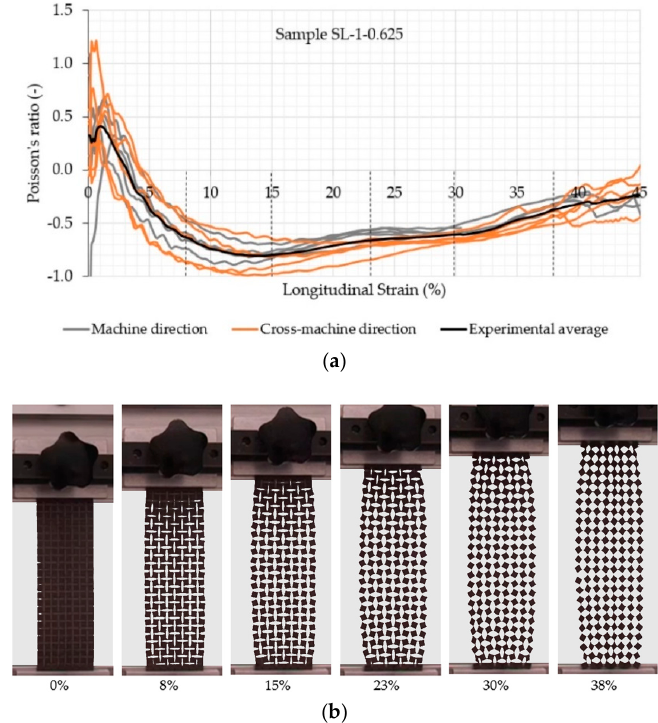
Figure 6. ( a ) Evolution of the Poisson’s ratio with the longitudinal strain of the auxetic sample SL-1-0.625 and ( b ) fabric deformation at different longitudinal strains during tensile testing in the machine direction.